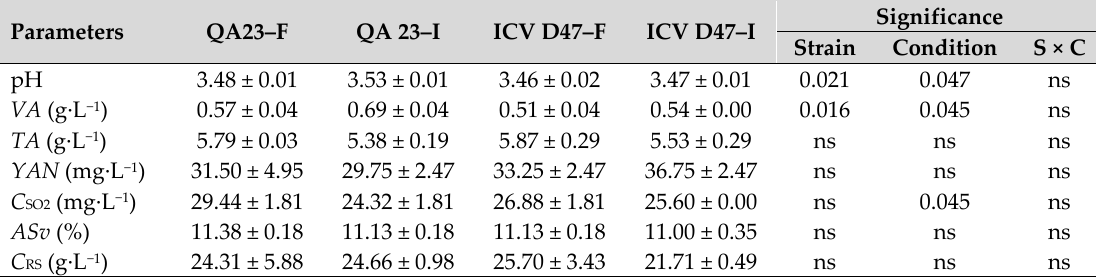
Table 1. Physicochemical characteristics (mean values and standard deviation) of mead fermented by S. cerevisiae QA23 and ICV D47 with free cells (F) or immobilized cells (I) and significance of the factors strain (S) and condition (C) according to two-way ANOVA.